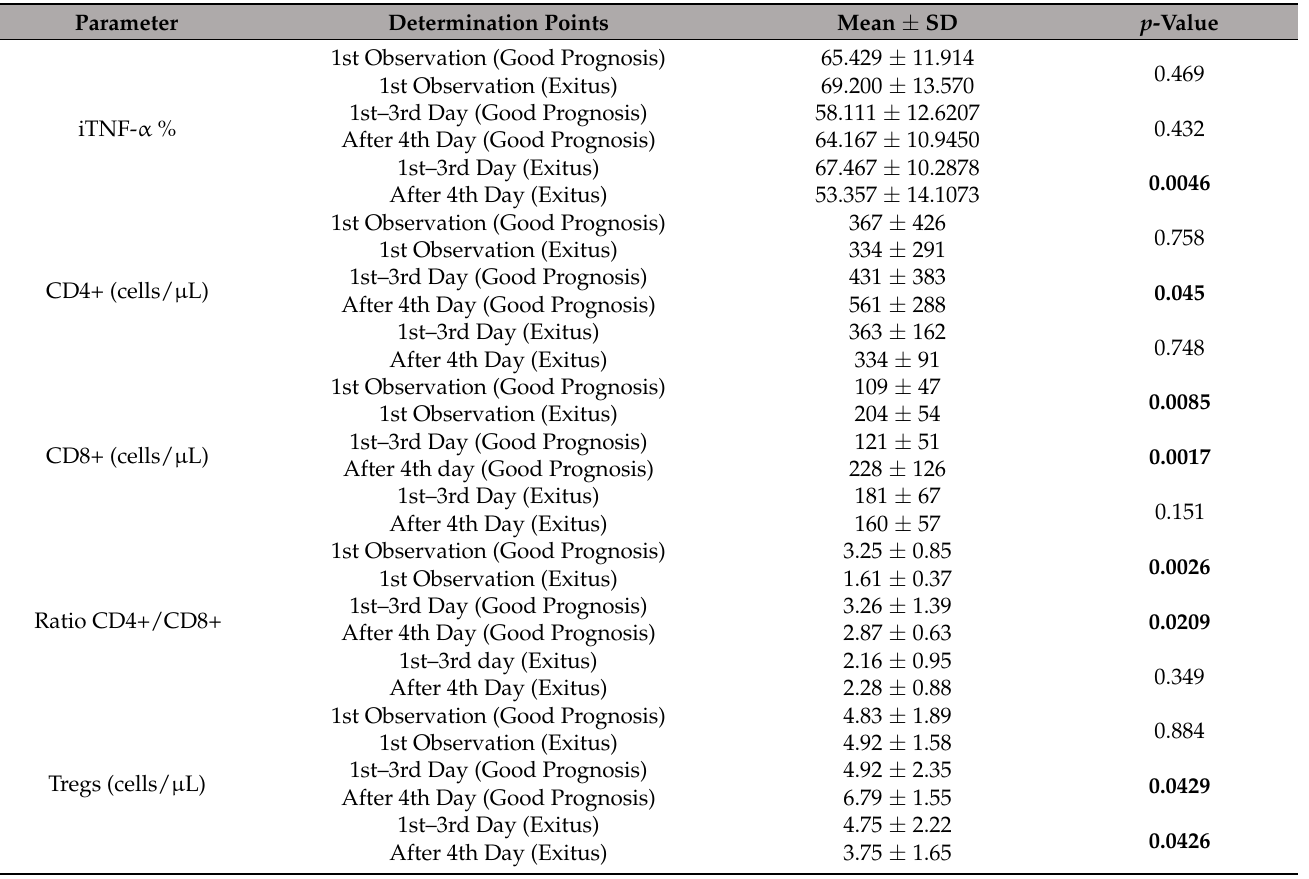
Table 4. Analysis of iTNF- α , CD4+ lymphocytes, CD8+ lymphocytes, CD4+/CD8+ lymphocytes ratio, and Tregs at different time points. Mean, deviation standard, and p -value at first observation, between the first and third observation, and from the fourth observation onwards among good prognosis and exitus patients. The significant p -values are shown in bold.